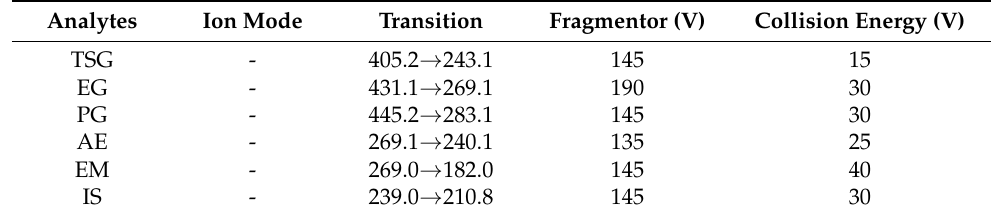
Table 7. The optimized mass spectrometry parameters of the five constituents of RM and IS. Analytes Ion Mode Transition Fragmentor (V) Collision Energy